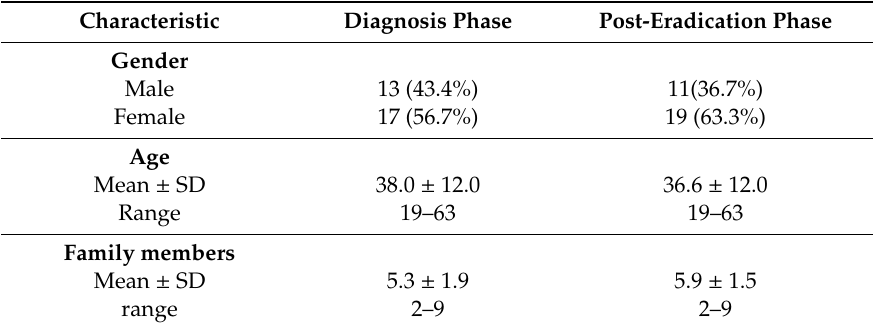
Table 1. Data of the study population in diagnosis and post-eradication phases.